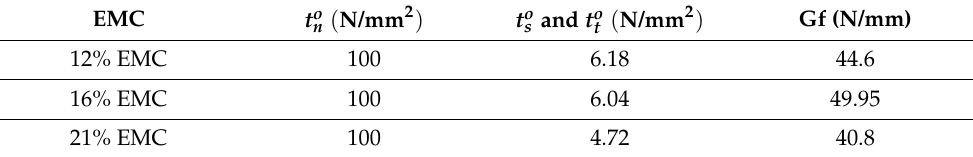
Table 20. 260 × 270 mm CLT damage initiation and evolution values.